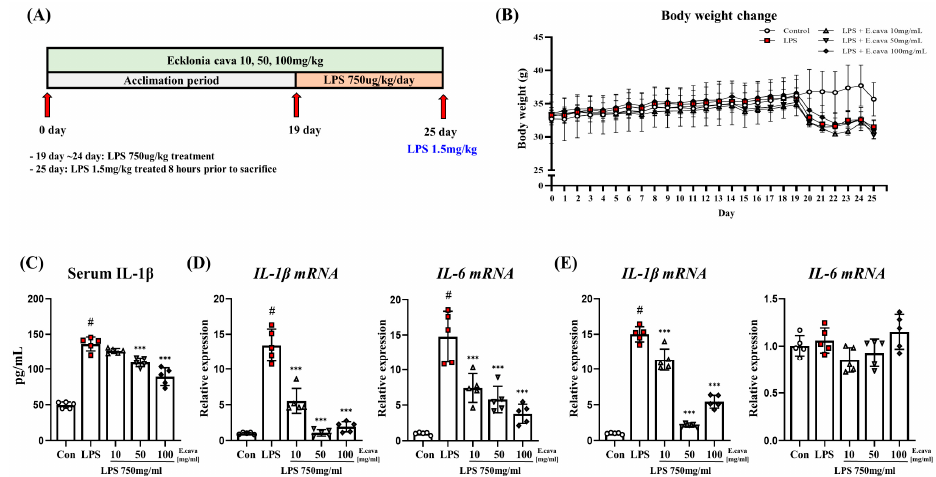
Figure 1. E. cava decreases pro-in fl ammatory cytokines levels. ( A ) The schematic diagram displays the schedule of animal experiments. The mice ( n = 25) were divided into fi ve groups ( n = 5 control group, n = 5 Lipopolysaccharide (LPS) group, n = 5 LPS + E. cava 10 mg/kg group, n = 5 LPS + E. cava 50 mg/kg group, n = 5 LPS + E. cava 100 mg/kg group). For 25 days, they were injected orally, and the control group was treated with the same capacity of distilled water, which was used for the E. cava extract treatment. On day 19, LPS was treated at 750 ug/kg/body weight for a week. The mice were sacri fi ced before 8 h LPS treatment at 1.5 mg/kg/bodyweight, and their organs were isolated. ( B ) Change of mouse body weight ( C ) Serum blood IL-1 β level measured after sacri fi ce. ( D ) QRT-PCR measured IL-1 β and IL-16 genes mRNA levels in the cerebrum of each group of male mice. ( E ) QRT-PCR measured IL-1 β and IL-16 genes mRNA levels in the hippocampus. RPLP0 was used for internal control. The points on the graph are represented by di ff erent shapes, with a white circle indicating the control group, a red square indicating the LPS group, a triangle representing the LPS + E. cava 10 mg/kg group, an inverted triangle indicating the LPS + E. cava 50 mg/kg group, and a rhombus representing the LPS + E. cava 100 mg/kg group. The di ff erences between means were obtained through one-way ANOVA, and then a Tukey post-analysis. The values represent means ± S.D. # p < 0.001 vs. control group and *** p < 0.01 vs. LPS group.